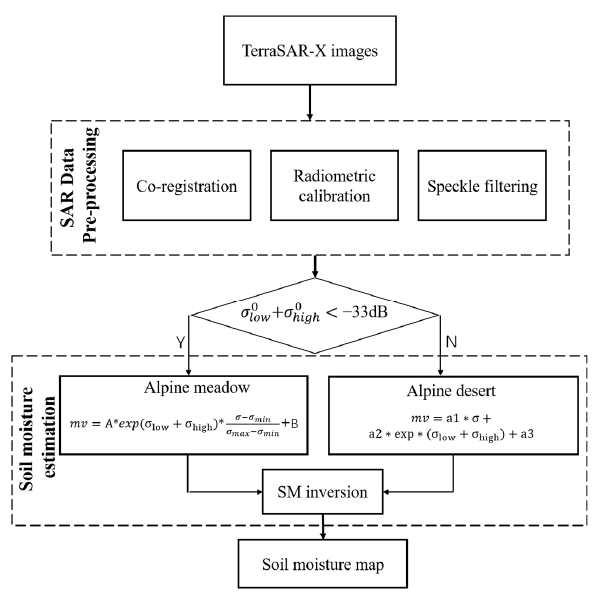
Figure 8. Flowchart for the proposed SM estimation models.